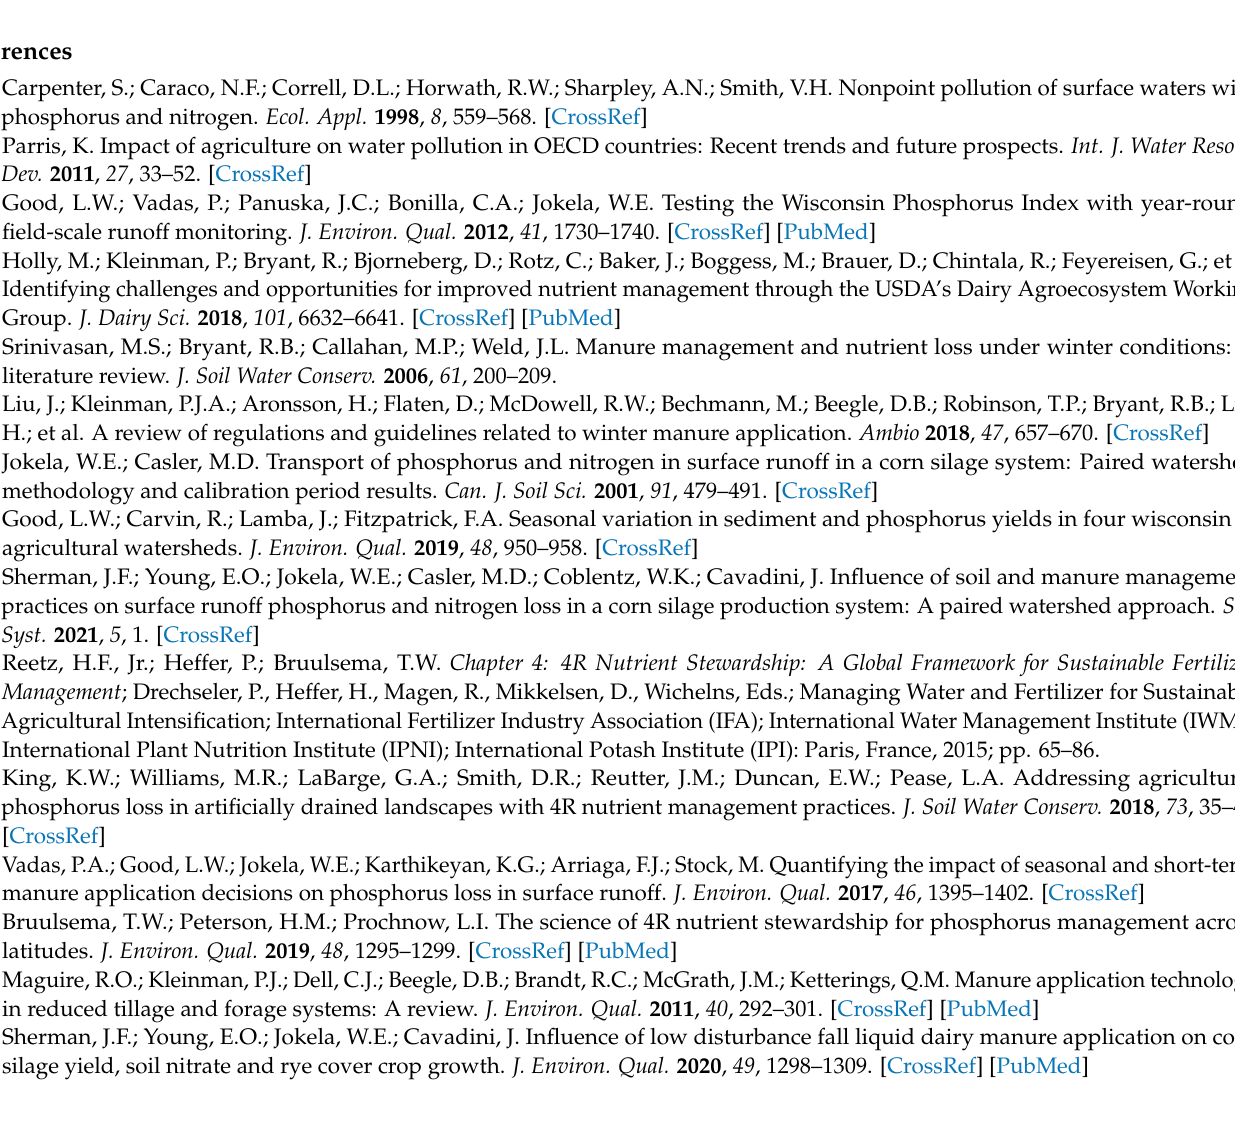
Figure S3: Snowmelt runoff organic nitrogen concentrations/loads by treatment for each site and year of the experiment. Asterisks indicate a significant ( p ≤ 0.05) main effect of manure solids content. Cumulative loads without a common lower-case letter differ ( p ≤